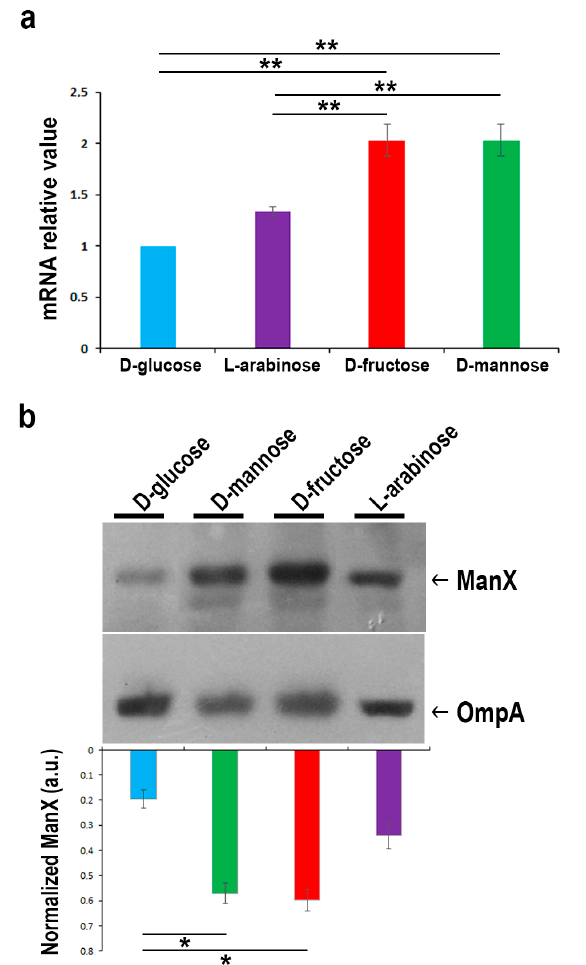
Figure 3. Comparison of manX gene and protein expression levels in strain CFT073 grown on M9 medium supplemented with 0.5% of the indicated sugars. ( a ) Real time-PCR analysis of manX mRNA. Total bacterial RNA was isolated from strain CFT073 grown to the mid-exponential phase, as described in the “Materials and Methods” section. The 16S rRNA gene ( rrsG ) was used as the normalizer. Data shown are fold increase ( ± SD) in manX mRNA relative to the d -glucose sample, considered 1. ( b ) Western blot analysis of ManX. Total proteins from bacteria under the same experimental conditions were separated by SDS / PAGE, transferred onto nitrocellulose, and probed with monoclonal anti-ManX antibody. The OmpA protein was used as the normalizer. Bars represent the amount of ManX calculated by densitometric analyses and expressed as arbitrary units (a.u.). Data represent the mean of three independent experiments. Asterisks indicate p values evaluated by one-way ANOVA; ** p ≤ 0.01, * p ≤ 0.05.